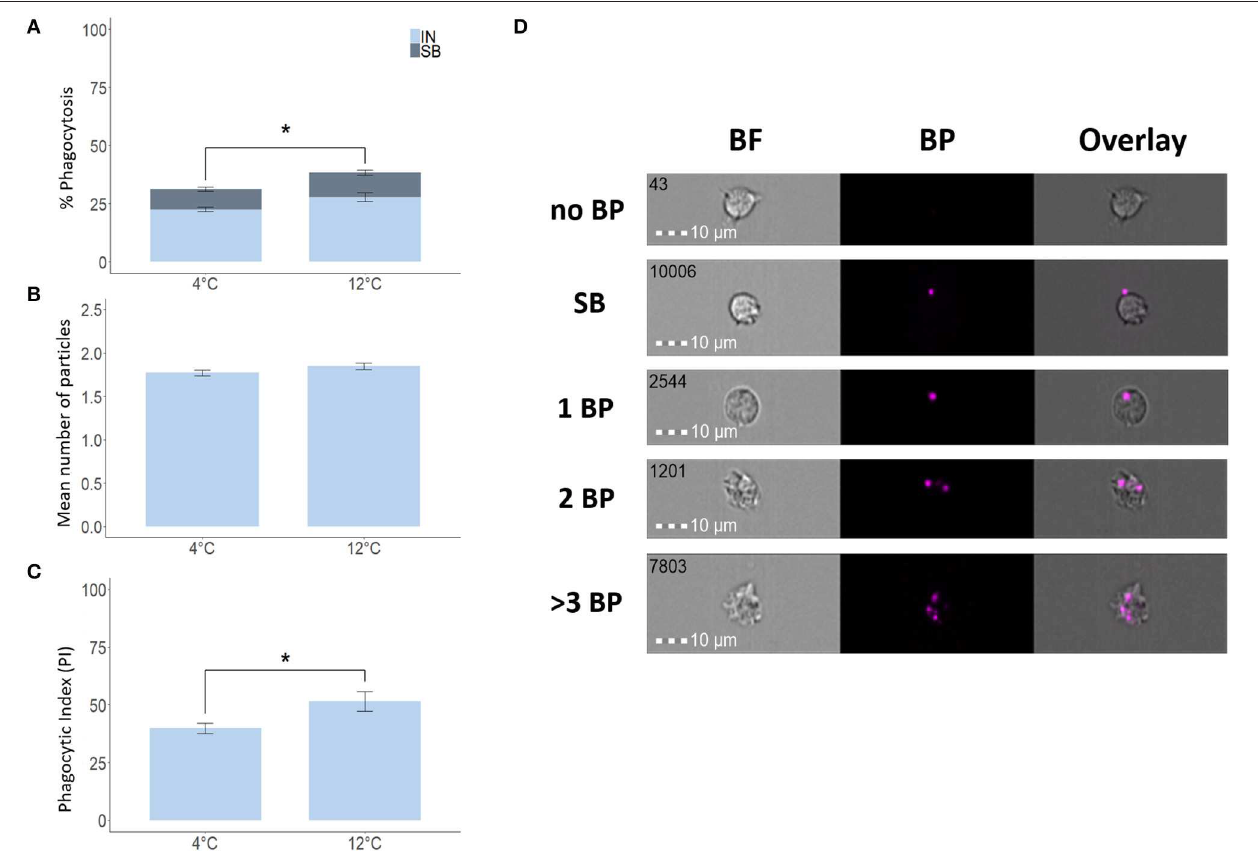
FIGURE 5 | Phagocytosis of Atlantic salmon head kidney macrophages incubated at different temperatures. Percent of phagocytic cells (A) , mean number of particles ingested per phagocytic cell (B) and phagocytic index, PI (C) . Representative cell images that show cells with no BP, SB, and 1BP, 2BP, and > 3BP (D) . Statistically significant differences ( p < 0.05) are indicated using asterisks. Bar plots show the mean ± SD. Sample size = 6. All cell images were captured with 40 × objective. Scale bar = 10 µ m. IN, internalization; SB, surface-binding particles; 1 BP, 2 BP, and > 3 BP, 1–3 internalized bio-particles; BF,